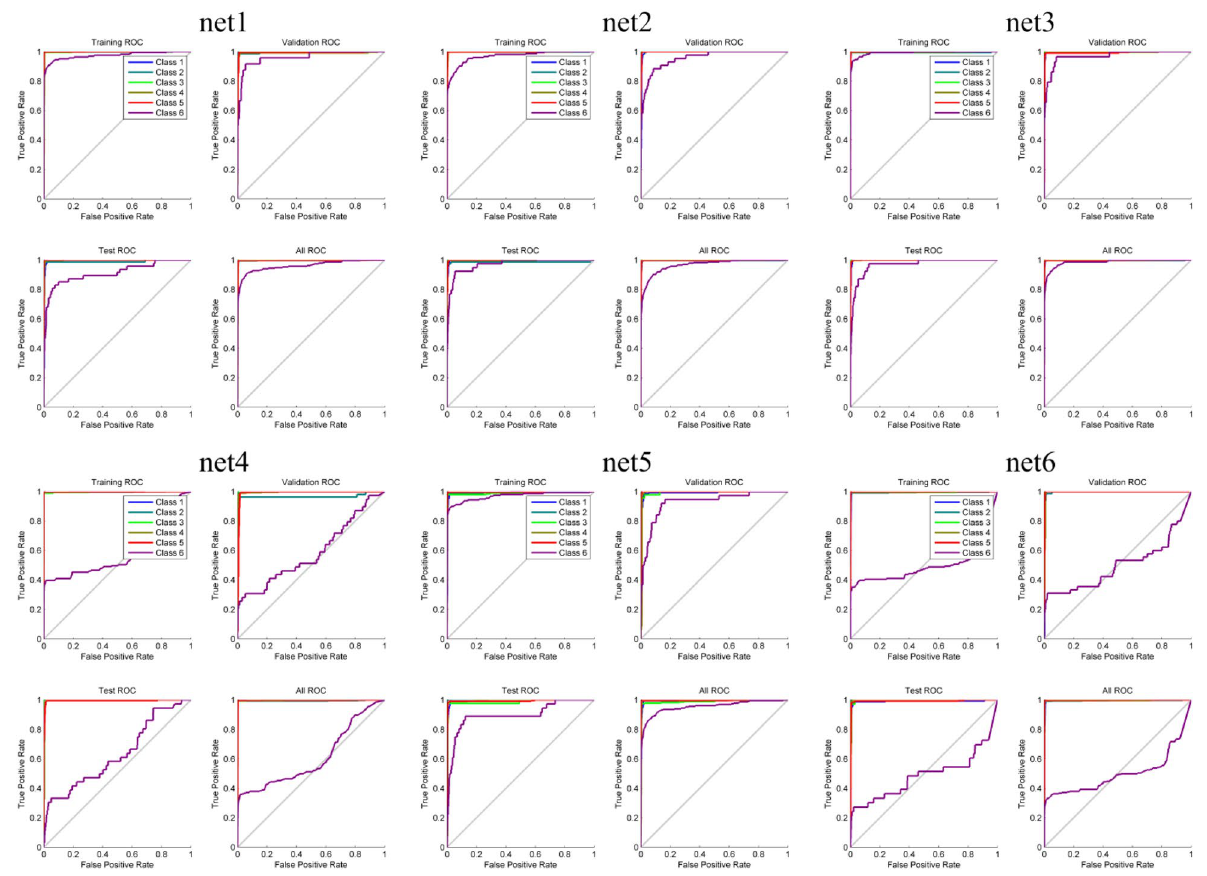
Figure 6. Receiver operating characteristic for the different neural networks. The class number of the different behavioral categories can be seen in Fig.